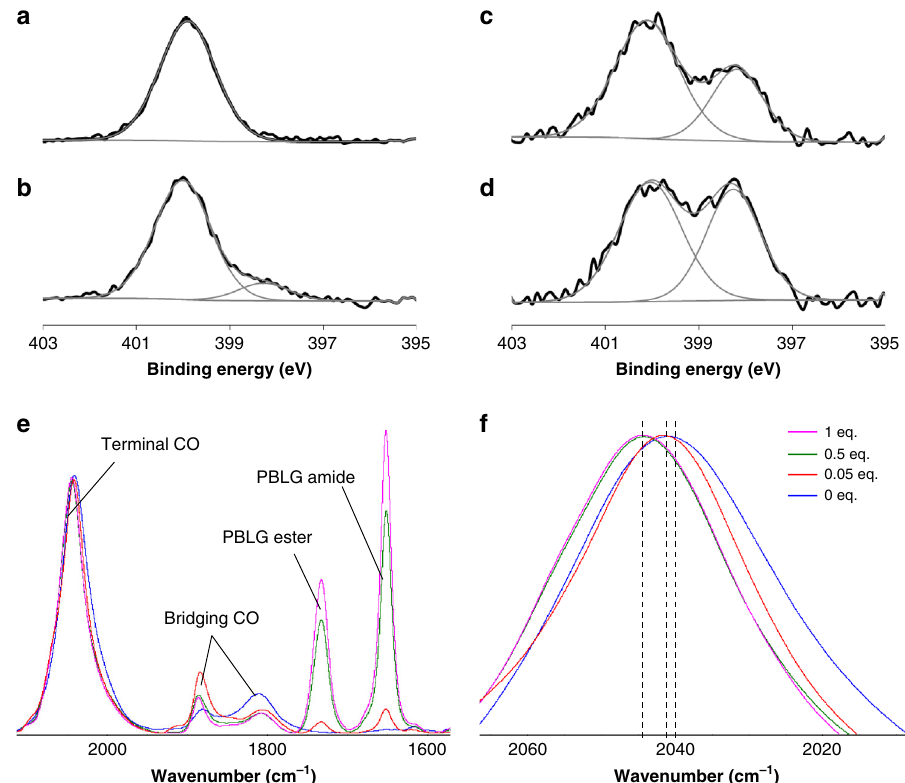
Fig. 3 Spectroscopic signature of coordination of the peptidic polymer to the nanoparticle surface. a XPS spectrum at the N 1s edge of PBLG4 alone. XPS spectra at the N 1s edge of assemblies between platinum nanoparticles and PBLG4 at: b 1 eq. (12% of component at 398 eV); c 0.5 eq. (33% of component at 398 eV); d 0.05 eq. (45% of component at 398 eV). e Infrared spectra of CO coordinated at the nanoparticle surface and of peptide bond of the polymer within the assemblies (at 0 eq., 0.05 eq., 0.5 eq., and 1 eq.). The spectra are normalized to the signal of the CO vibration around 2040 cm − 1 . f Zoom on the infrared spectra of Fig. 2e at the terminal CO region. The assembly process is characterized by a speci fi c signature both in XPS and infrared